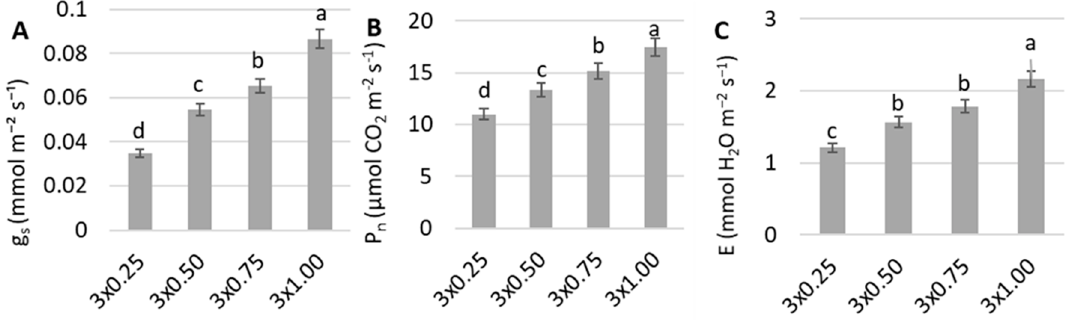
Figure 3. Effect of distances between trees on the stomatal conductance g s ( A ), photosynthetic rate P n ( B ), and transpiration rate E ( C ). The different letters in graphics indicate significant differences. The data presented as an average of three measurements during the season. The data were processed using analysis of variance (Anova), the Turkey (HSD) test at the confidence level p = 0.05.